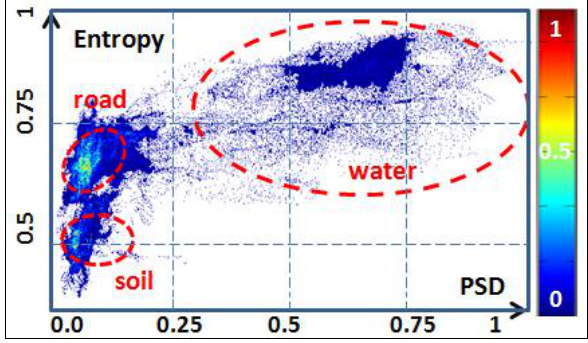
Figure 12. The normalized Entropy-PSD feature